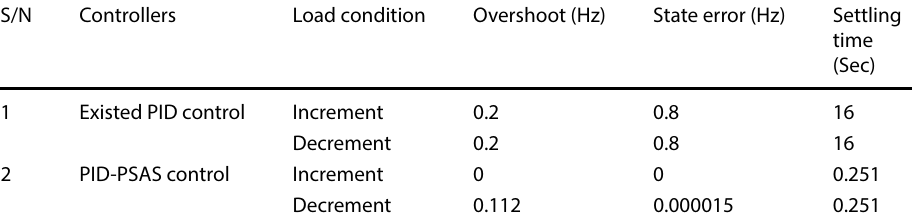
Table 5 Summarized results in load disturbance decrement and increment with existed and proposed